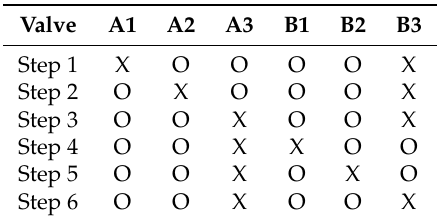
Table 2. The two pumps (A and B) each follow the same sequence of steps, but are configured so that each operates its set of three valves only when the other set is not changing (where O represents the valve open and passing fluid, and X represents the valve being closed and sealed). The cycles are completely independent here, but could operate with any degree of overlap or phase